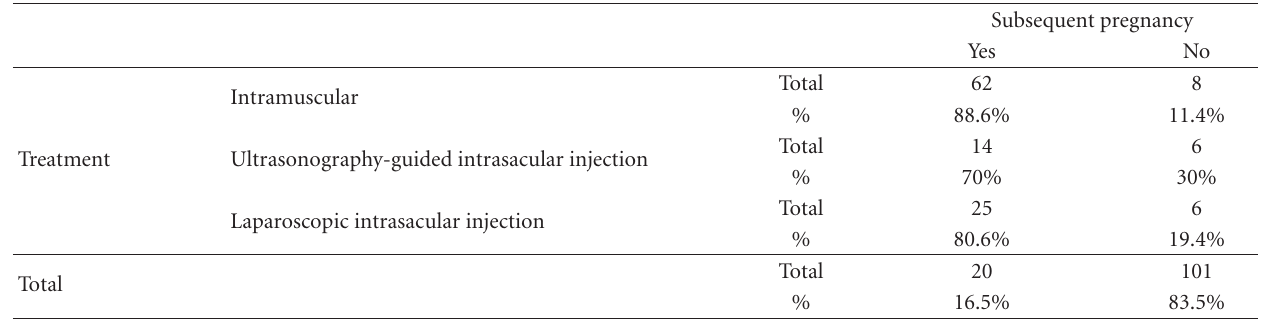
Table 3: Pregnancy rate according to treatment administered for ectopic pregnancy. Results are expressed as frequencies and percentage ( P = 0 . 127).